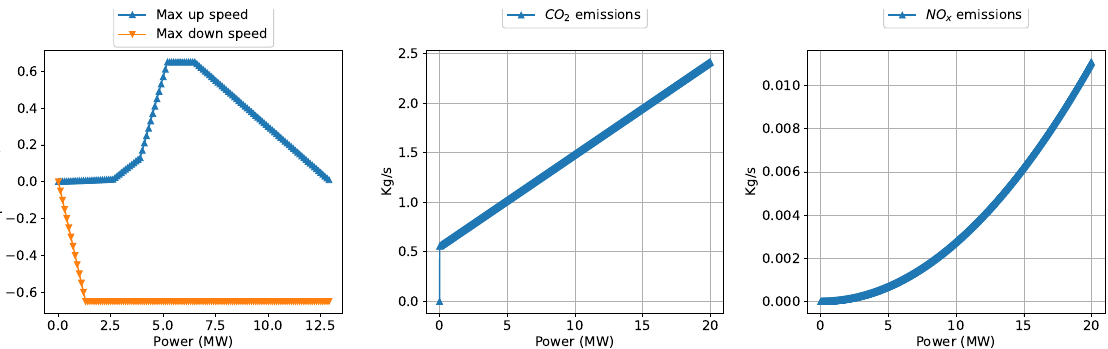
Figure 2. Maximum ramp-up and ramp-down, CO 2 , and NO x emissions, all as functions of the gas turbine-generated power.